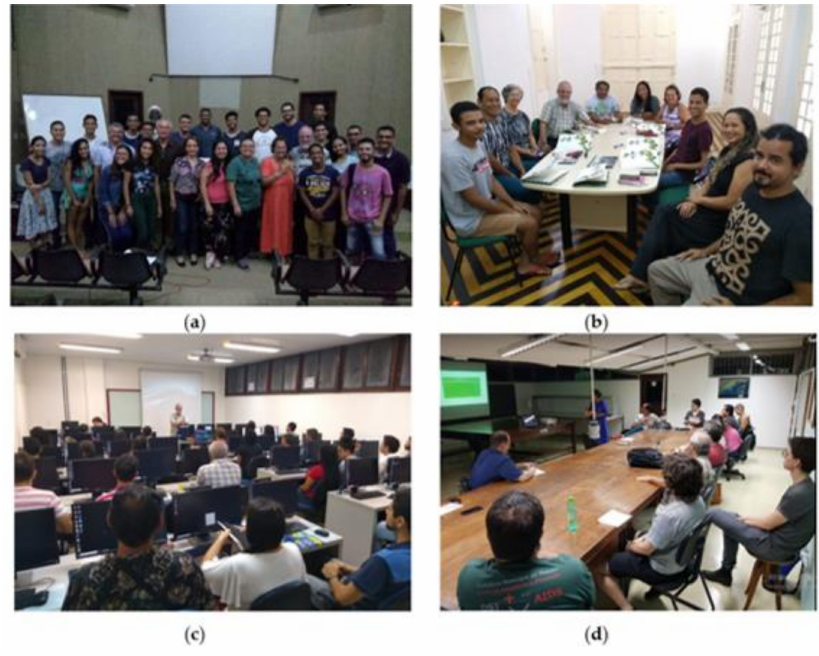
Figure 4. ( a )—Lecture at UFMA; ( b )—Meeting at CNPT; ( c )—Training on the Nunaliit platform; ( d )—Meeting at